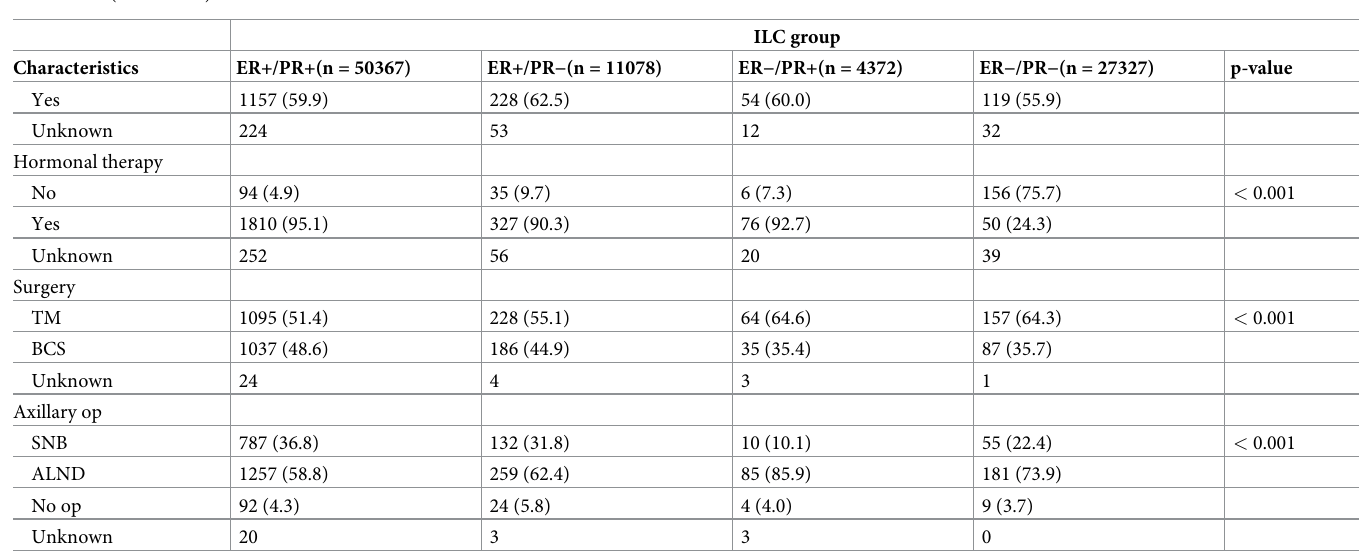
Comparison of survival between IDC and ILC in each hormone receptor expression subgroup We compared survival between the IDC and ILC populations in each hormone expression subgroup. There were no differences in survival between the IDC and ILC populations in the